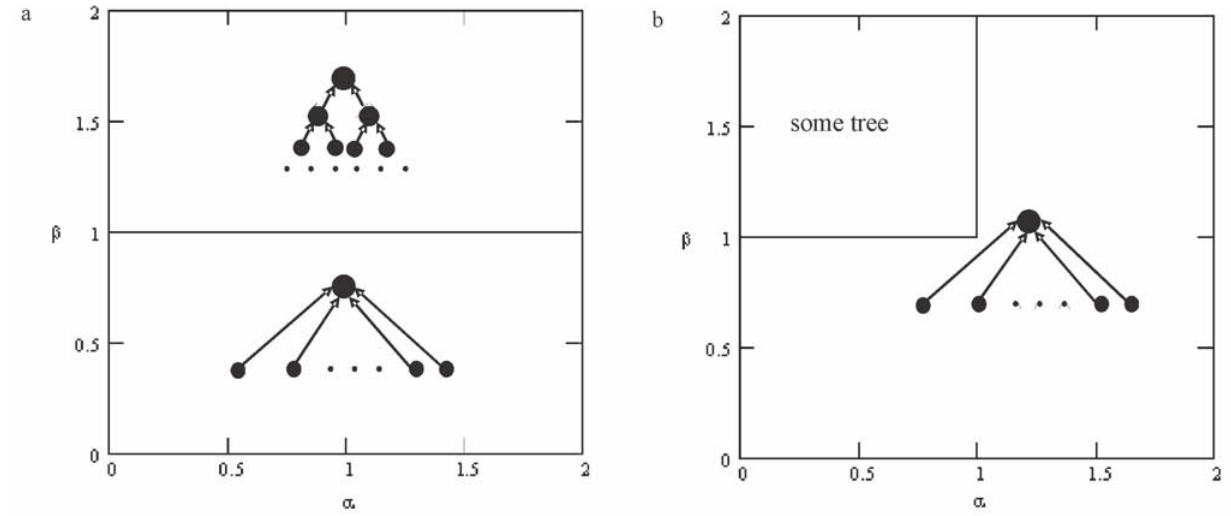
Fig 8. Forms of optimal hierarchy for function (I) (Fig a) and function (II) (Fig